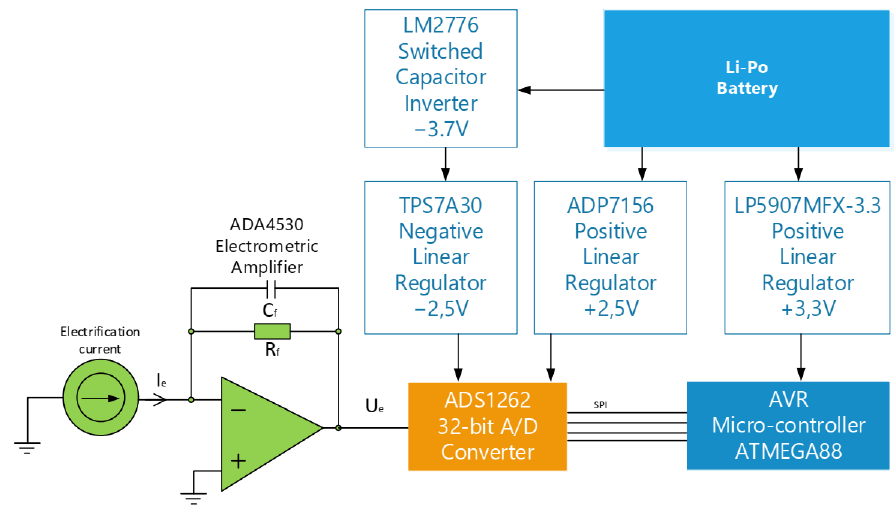
Figure 3. Schematic of current ammeter with low input bias electrometric amplifier and 32-bit delta–sigma analog-to-digital converter. A/D converter has internal precision voltage reference. Delta-sigma ADC with 32-bit resolution (ADS1262 from Texas Instruments) converts the electrometric voltage to a digital form and transfers it to the microcontroller using the serial interface. The device is battery powered to reduce electrical noises.